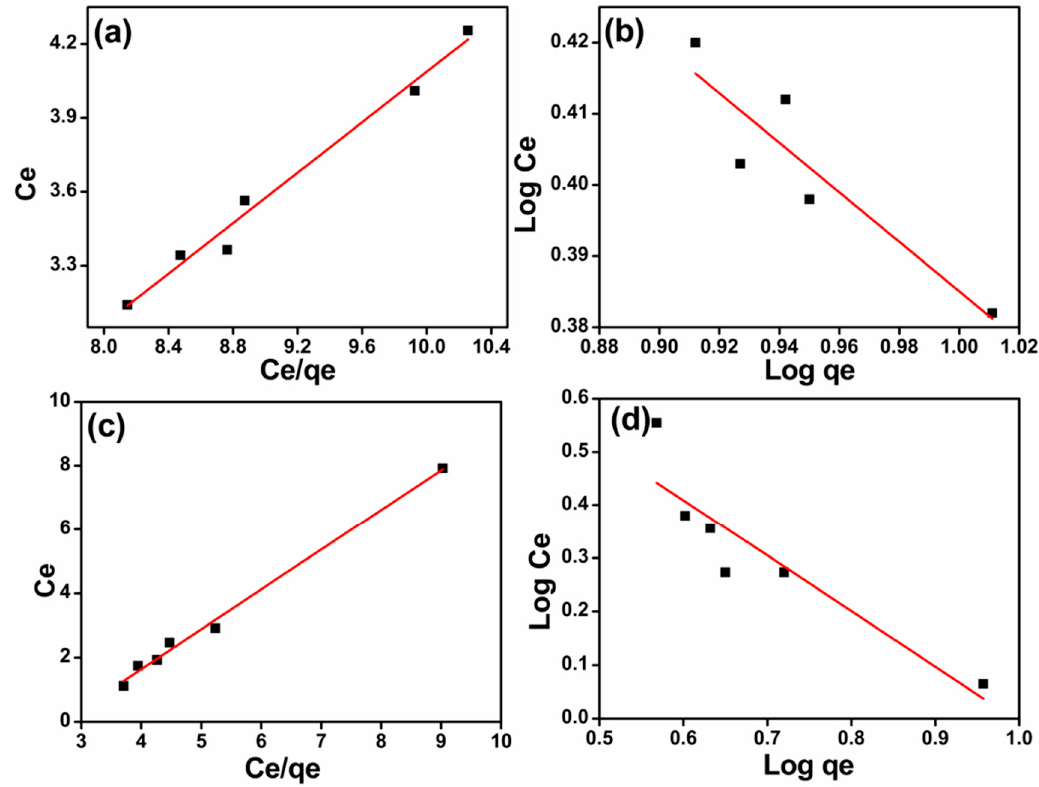
Figure 2. ( a , c ) Langmuir and ( b , d ) Fredundlich isotherms for Cd 2+ removal by T. fasciculatum and T. longibrachiatum , respectively. Table 2. Langmuir and Freundlich isotherm constants for removal of Cd 2+ by T. fasciculatum and T. longibrachiatum.